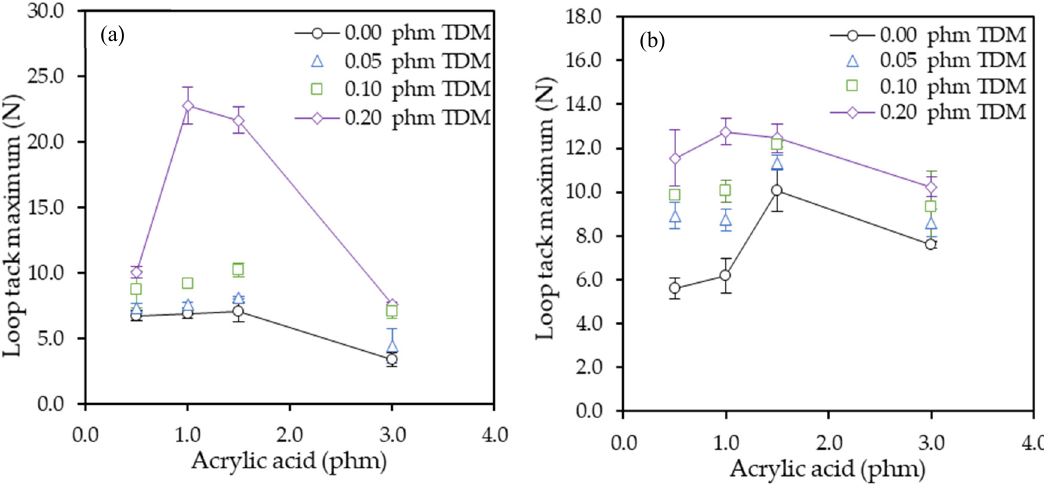
Figure 6. Effect of the acrylic acid and tert-dodecyl mercaptan (TDM) in the loop tack test on glass panels for ( a ) PET and ( b ) paper tapes.